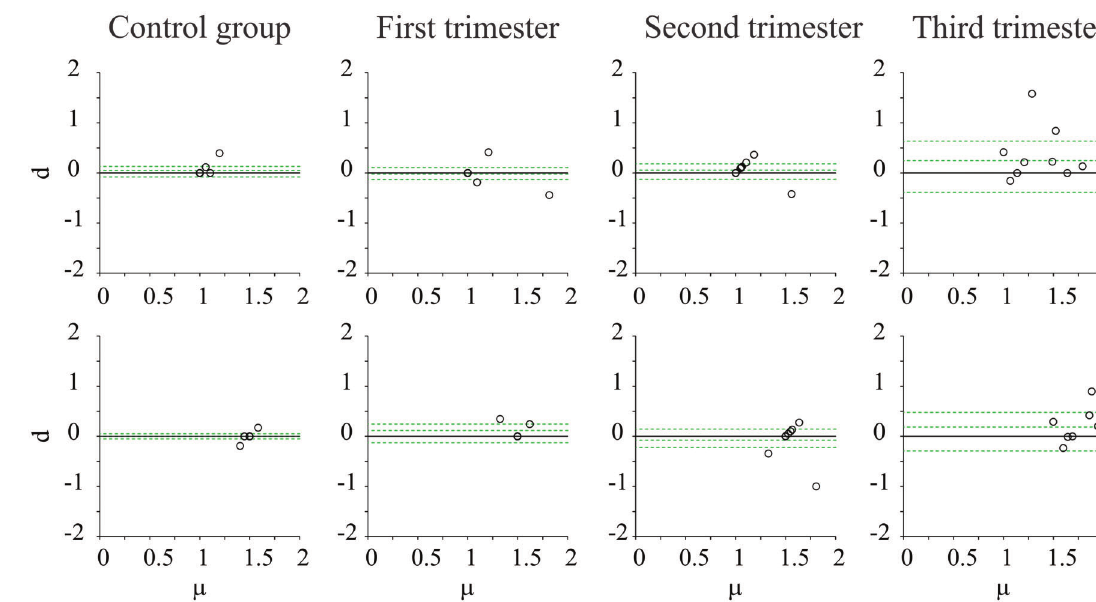
The data are reported as median ( fi rst quartile – third quartile). *P o 0.083 com- pared to Control (one-tailed Mann-Whitney test).